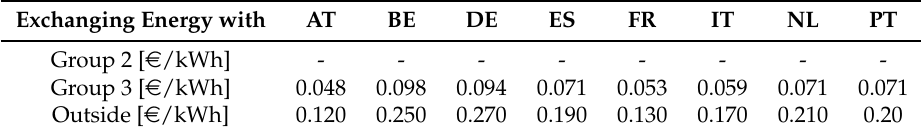
Table A2. Grid fees and taxes for procuring energy within Group 2, Group 3 and from outside of the